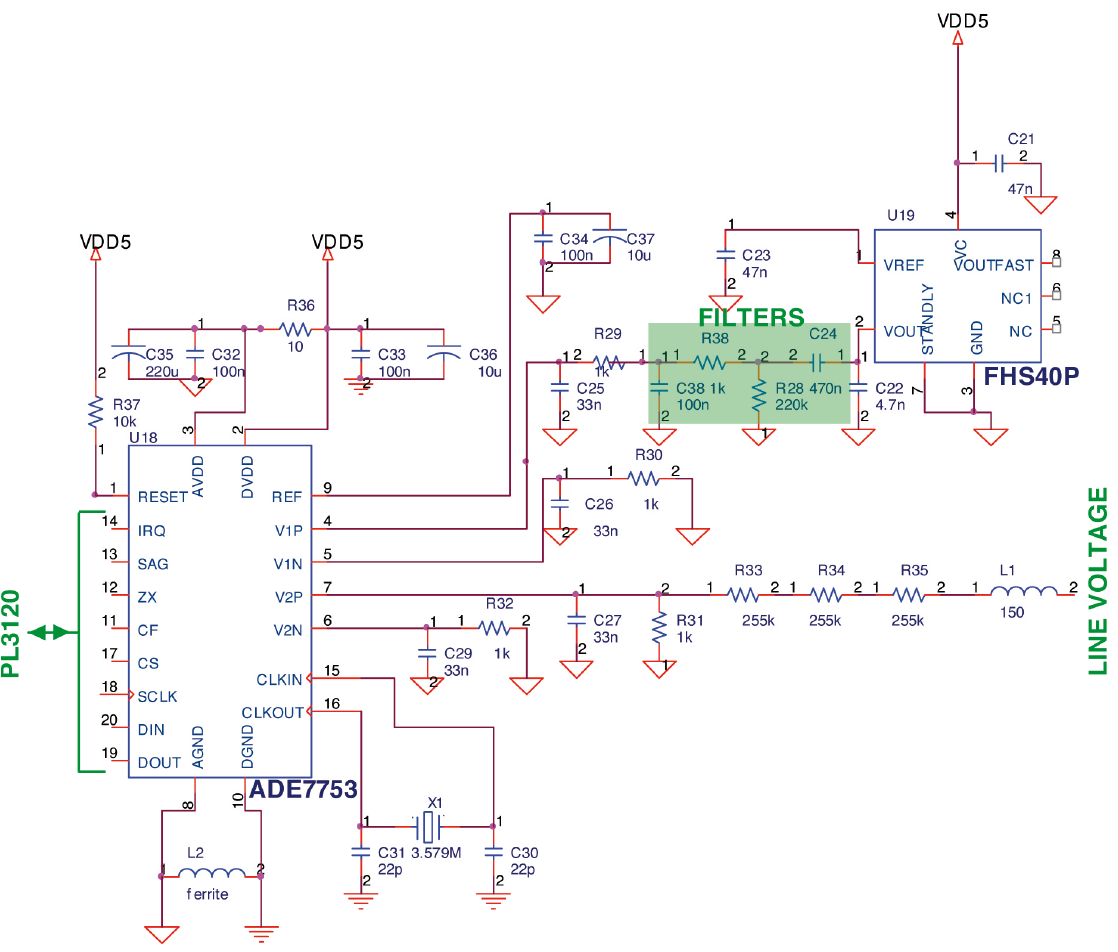
Figure 4. Schematic Detail of ADE7753 and FHS-40P